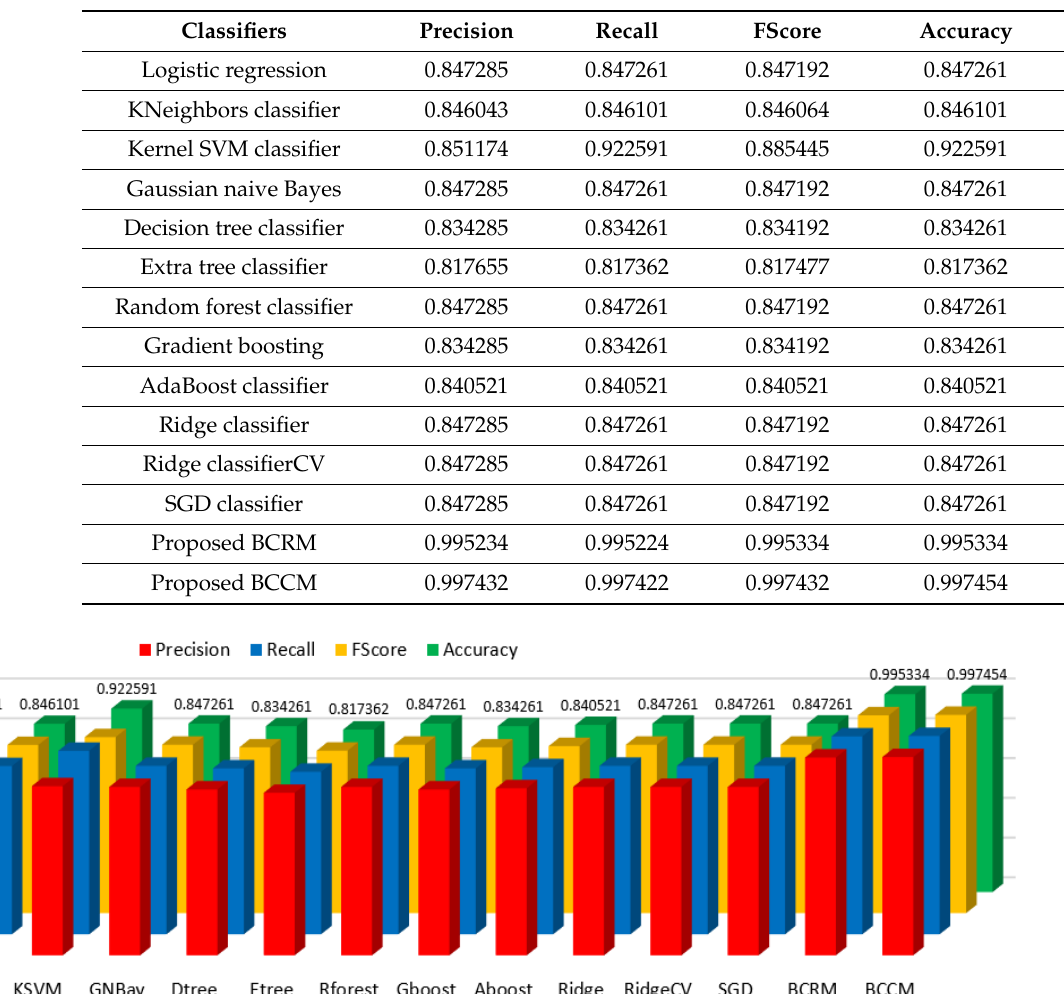
Table 29. Performance analysis of proposed BCRM and BCCM with existing classifiers.